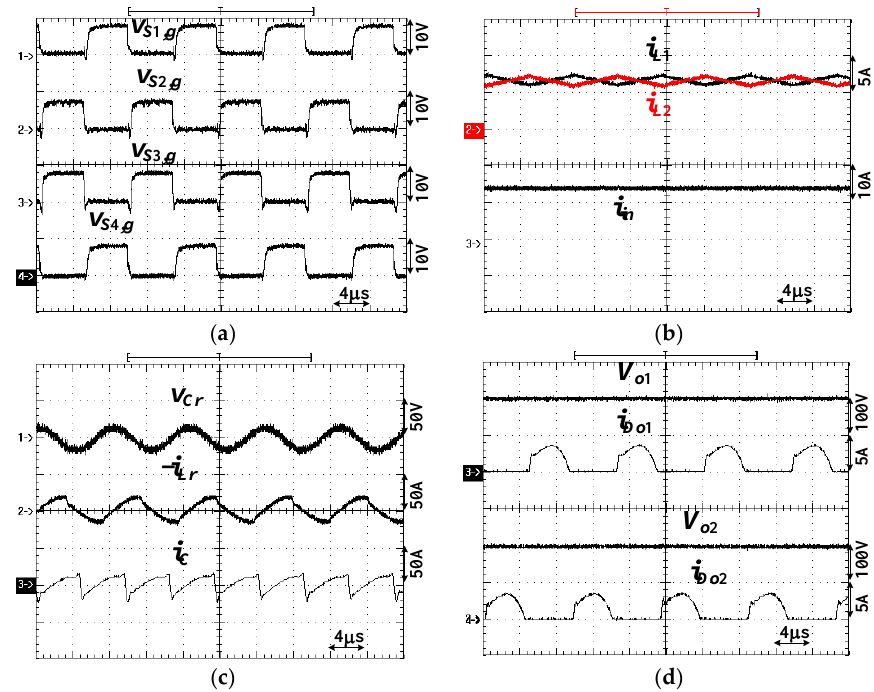
Figure 8. Test waveforms at V in = 39 V and rated power: ( a ) v S 1 , g ~v S 4 , g ; ( b ) i L 1 , i L 2 , i in ; ( c ) v Cr , -i Lr , i C ; ( d ) i Do 1 , i Do 2 , V o 1 , V o 2 .